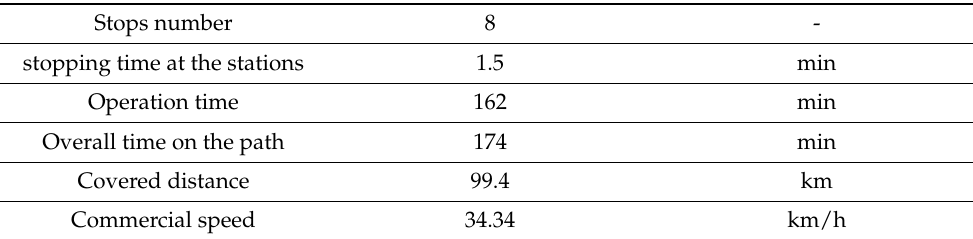
Table 3. Commercial speed